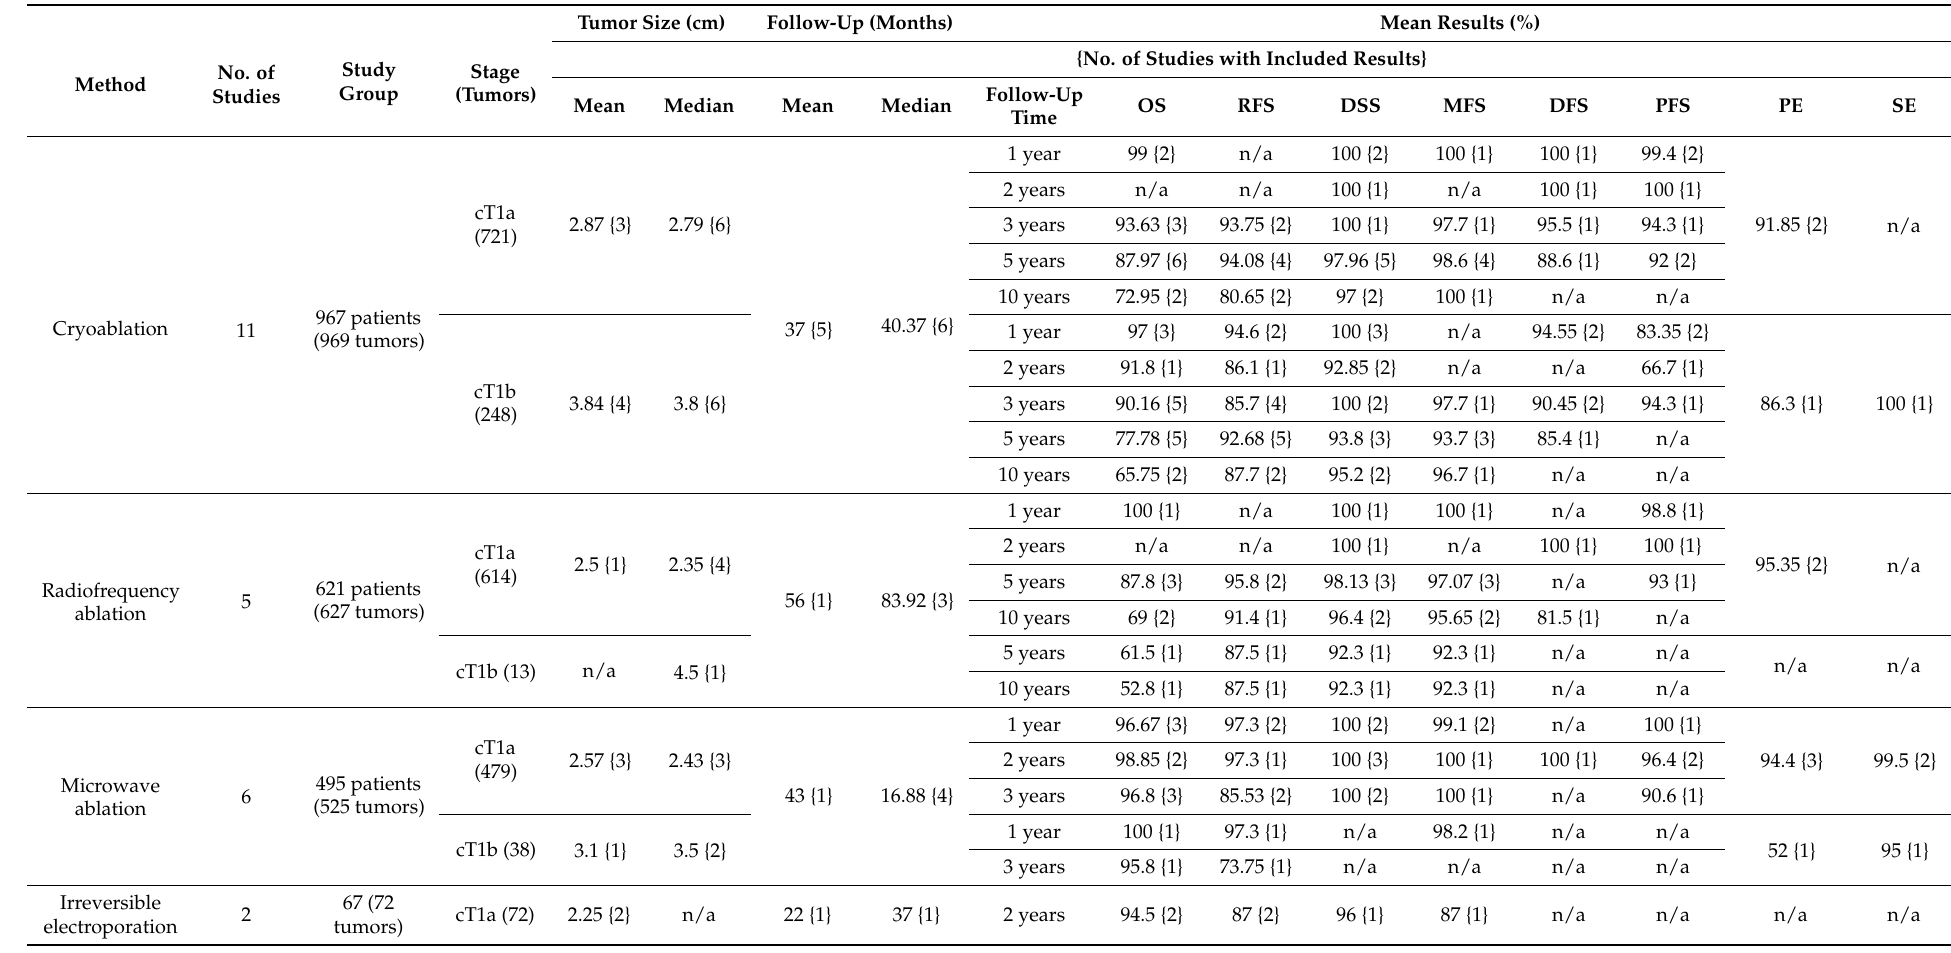
Table 2. Overview of mean results for ablative